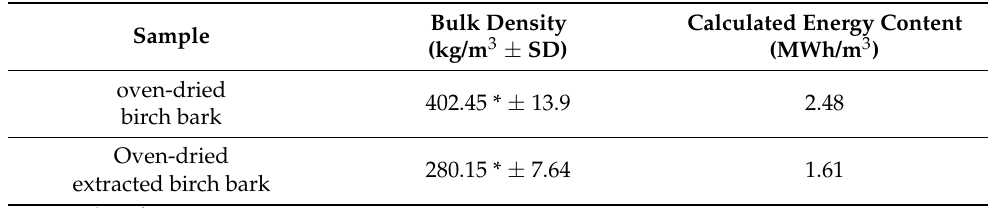
Table 2. Bulk density and calculated energy content (means ± standard deviation) of birch bark before and after